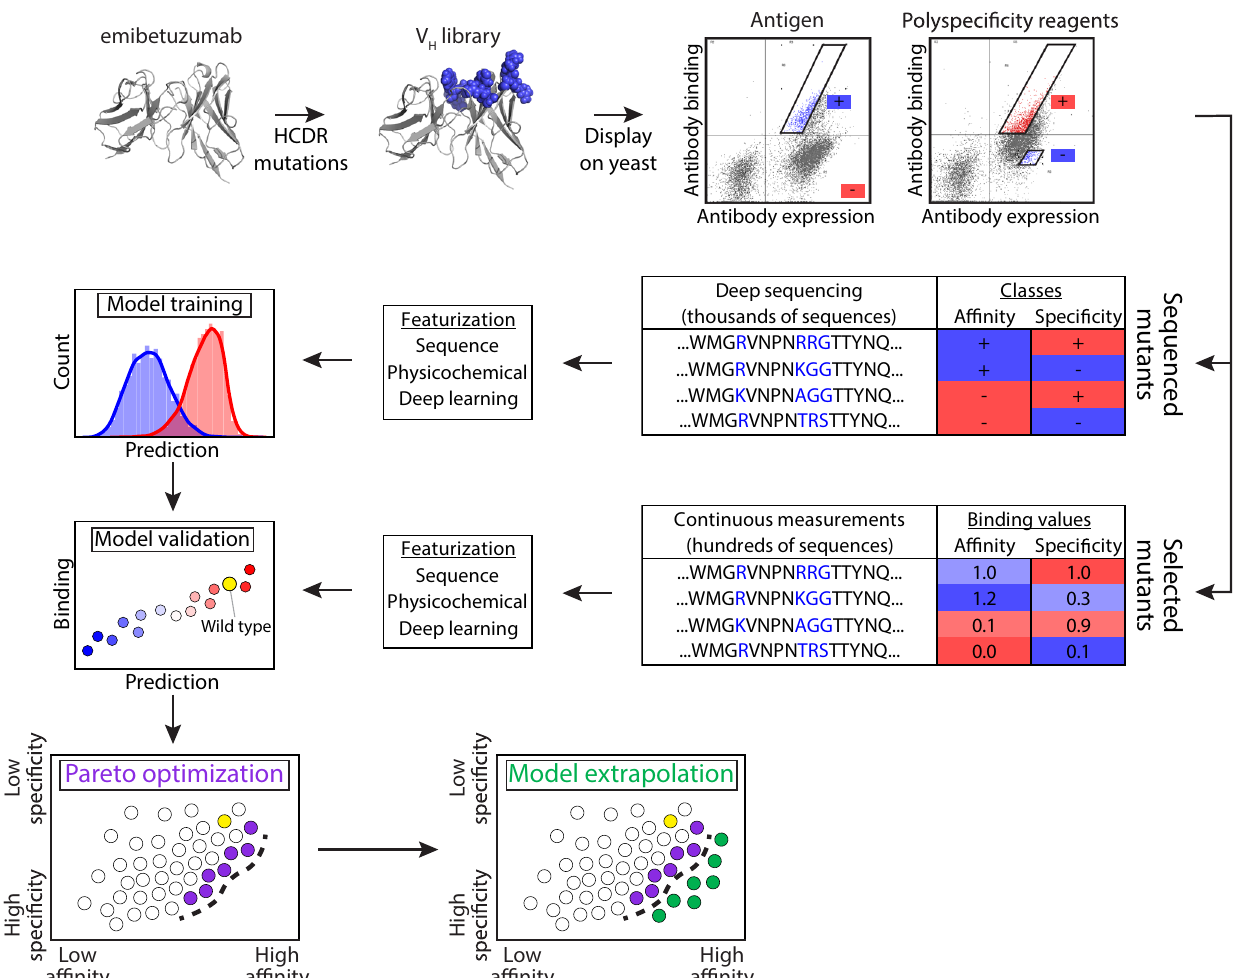
Fig. 1 Overview of antibody library sorting, deep sequencing, and machine learning methods used to co-optimize the af fi nity and speci fi city of a therapeutic antibody. A clinical-stage antibody (emibetuzumab) was mutated at eight positions in three heavy chain CDRs, and the antibody libraries were sorted using yeast surface display and magnetic- and fl uorescence-activated cell sorting for high af fi nity and high and low levels of non-speci fi c binding. The sorted libraries were deep sequenced, and the resulting antibody sequences were used to train models for predicting metrics correlated with antibody af fi nity and speci fi city (non-speci fi c binding) using different types of molecular features. These features included antibody sequences encoded as binary vectors, physicochemical features, and deep learning features. The resulting models were used not only to predict the classi fi cation of antibody af fi nity and speci fi city (e.g., high or low af fi nity), but also continuous metrics correlated with each property to predict intraclass variability (e.g., high vs. very high af fi nity). The model predictions were also used to identify antibody mutants in the library at the Pareto frontier that maximize antibody af fi nity to different extents while minimizing tradeoffs due to reduced speci fi city (i.e., increased non-speci fi c binding). Some of the models, which generalized to novel mutational space, were used to identify antibodies with even greater improvements in af fi nity and speci fi city than was possible in the experimentally sorted